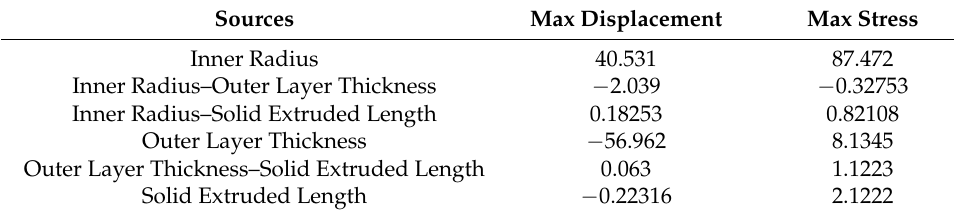
Table 4. The relative effects of the input parameters on the output